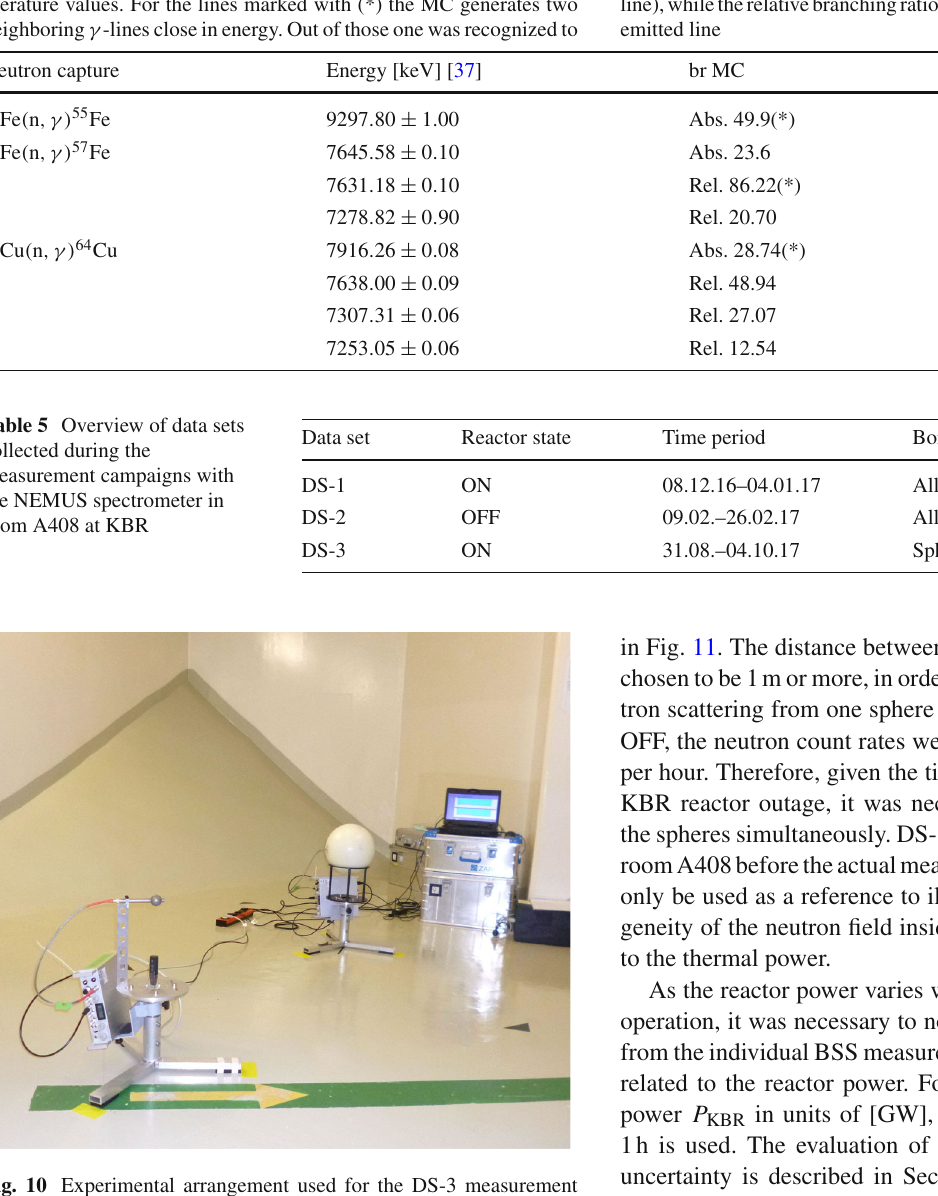
Fig. 10 Experimental arrangement used for the DS-3 measurement (reactor ON). The bare detector in the foreground was used as a monitor of the thermal neutron fluence rate. The Bonner sphere in the back was placed in the central CONUS position. Other Bonner spheres were placed on this position one after